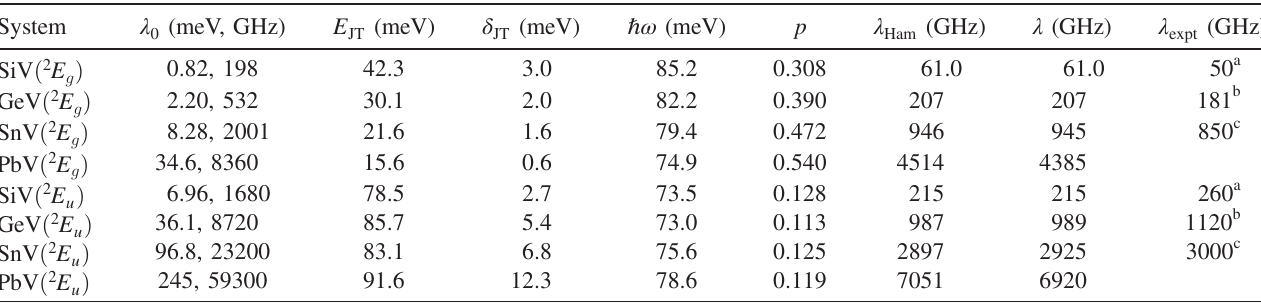
TABLE III. The calculated basic parameters of the APES such as E Jahn-Teller energy, δ barrier energy, and the ℏ ω energy of the e JT JT effective e phonon driving the Jahn-Teller effect are shown as well as the calculated λ 0 intrinsic spin-orbit coupling and p Ham g p λ 0 effective spin-orbit coupling for the 2 E optically ground state and 2 E excited state of reduction factor, and the deduced λ g u Ham ¼ X V ð − Þ defects. The calculated zero-field splitting ( λ ) is for comparison to the experimental value ( λ ). We determine the calculated λ expt values beyond the simple Ham reduction theory where we treat the SOC and DJT Hamiltonians simultaneously (see Fig. 5 for graphical